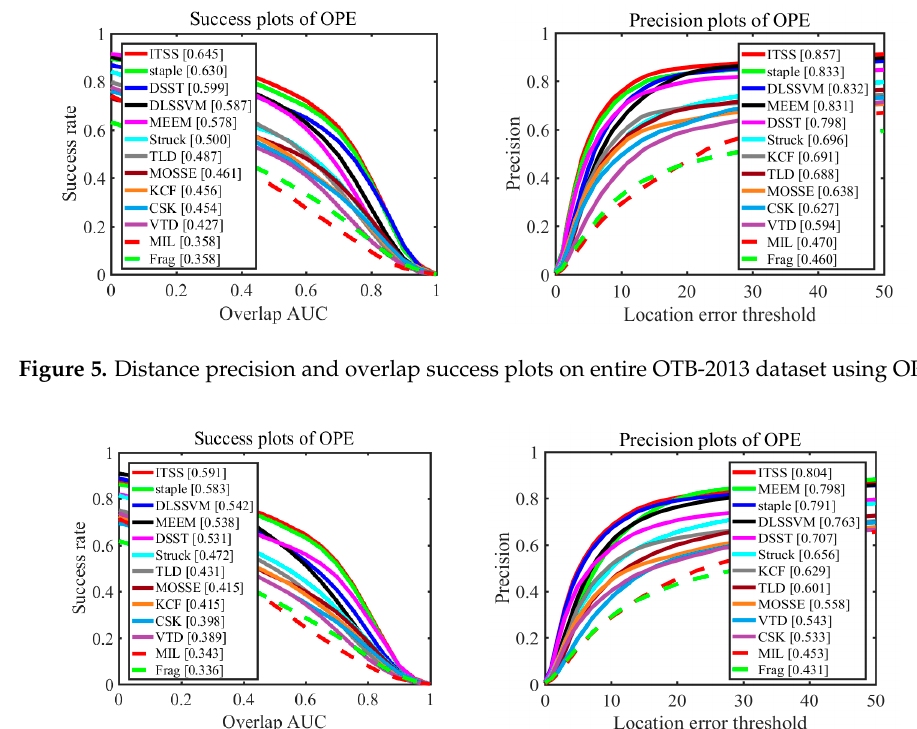
Figure 6 Distance precision and overlap success plots on entire OTB-2015 dataset using OPE.